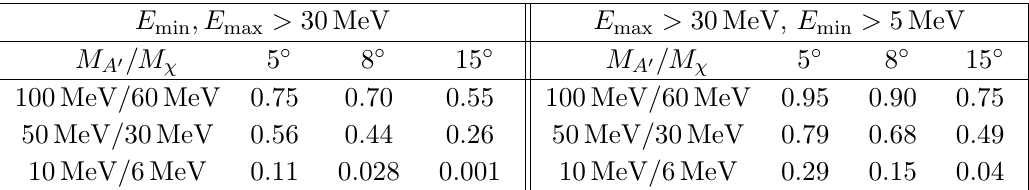
(cid:6) pair produced in DM trident events, estimated from